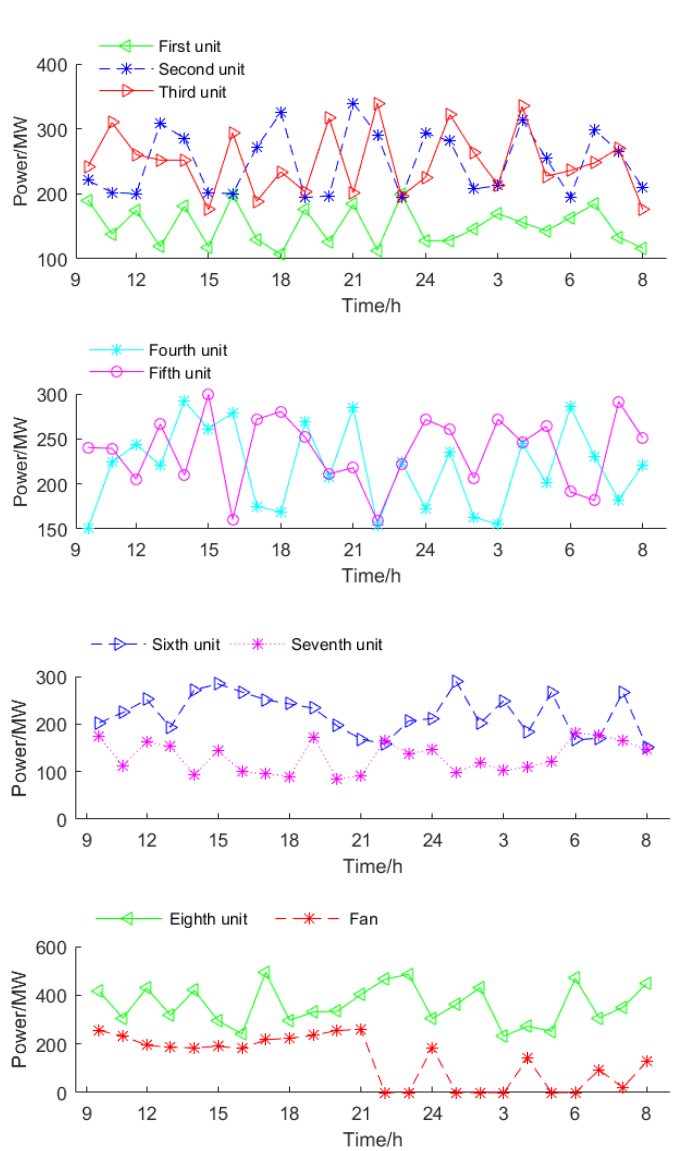
Figure 17. Output distribution of eight units and fans.